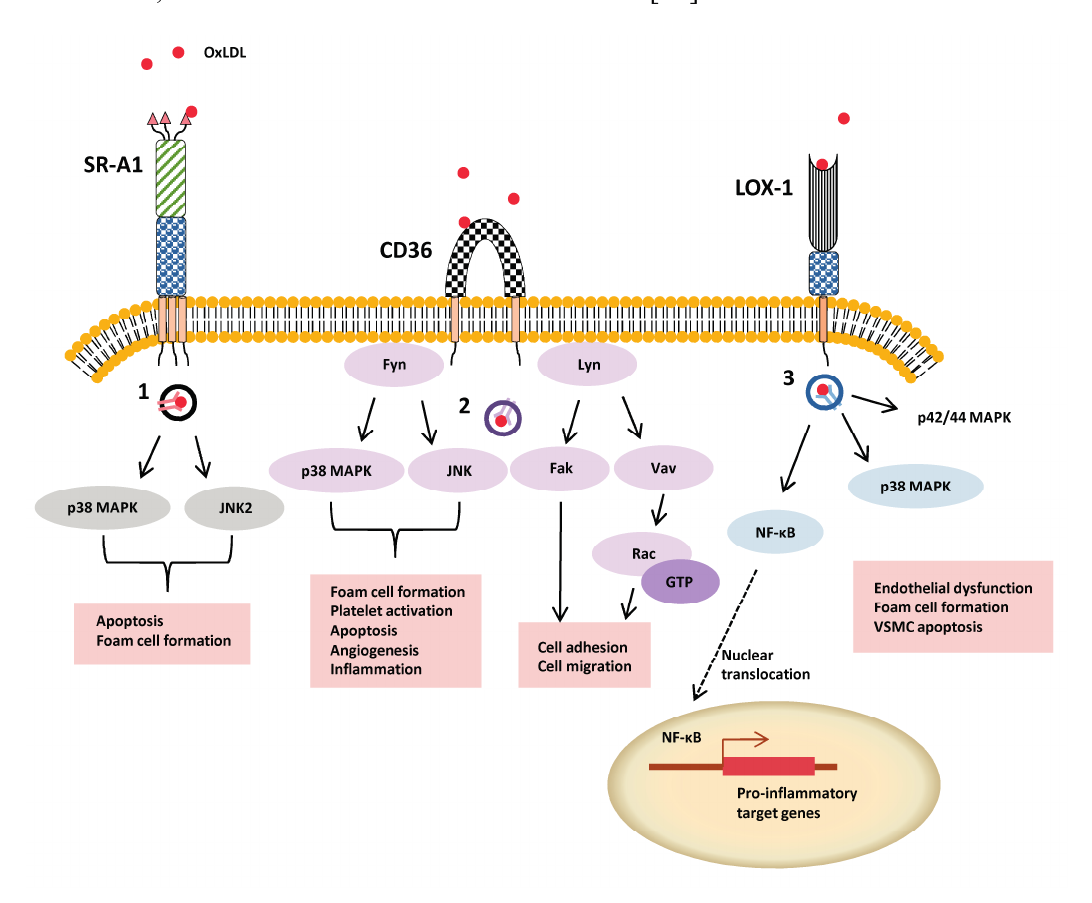
Figure 2. Schematic overview of ligand-stimulated SR signal transduction.